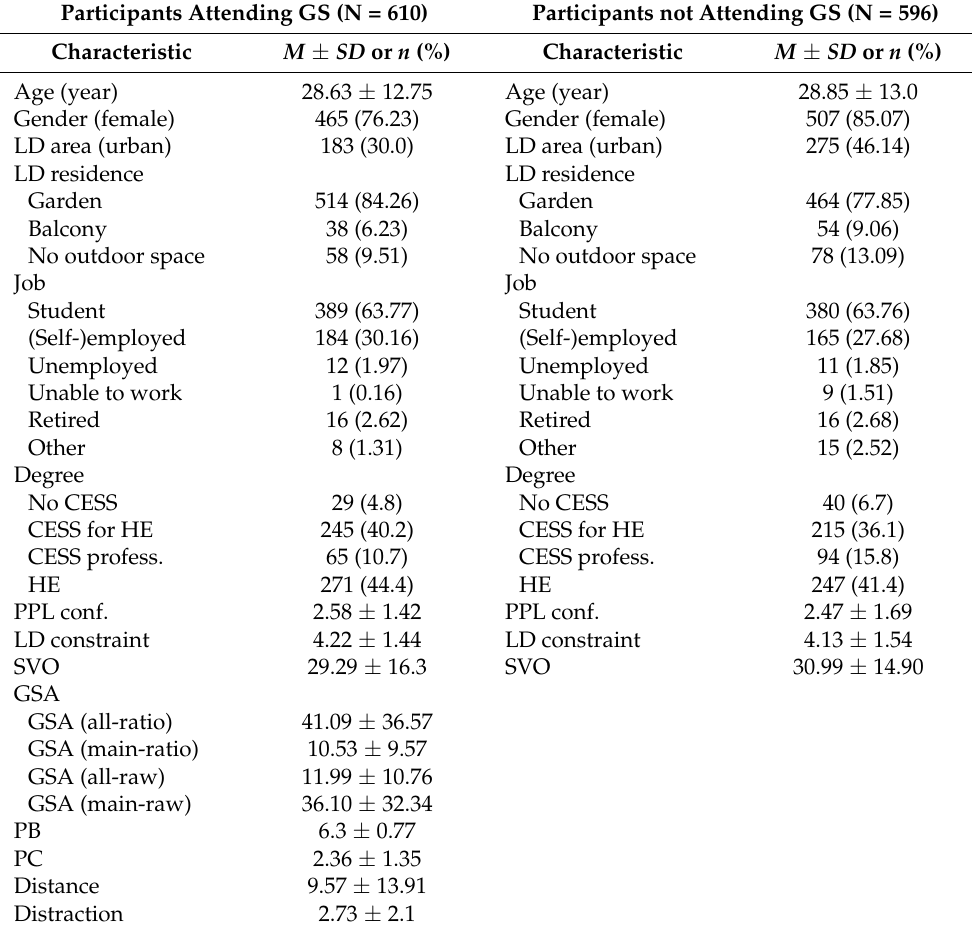
Table 1. Participants’ characteristics.